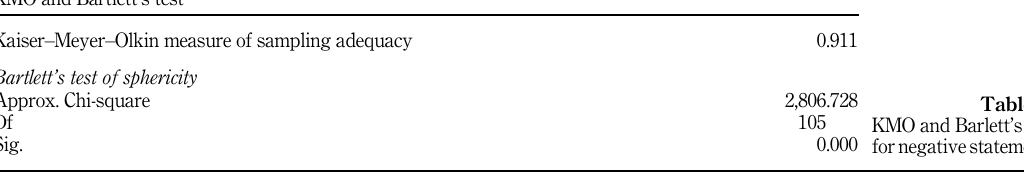
Table 1. KMO and Barlett ’ s test